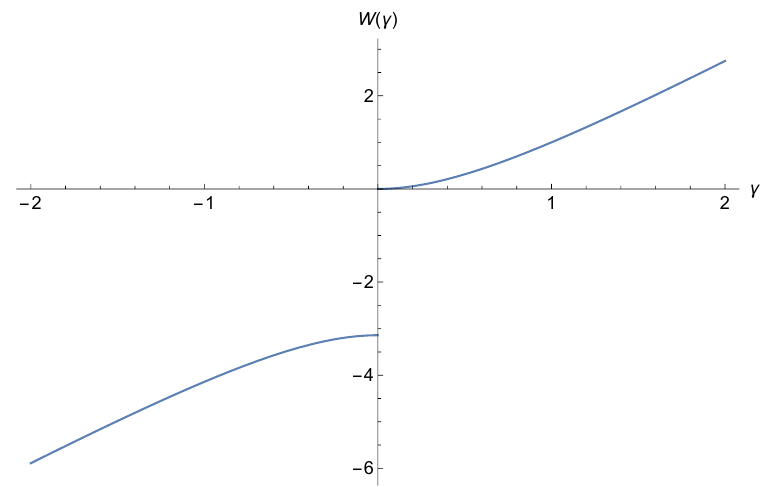
Figure 1: The scaling function for the effective potential W ( γ ) defined in Eq. (14). Note that although W is discontinuous at γ = 0 the potential V that although W is discontinuous at γ = 0, the potential V function of λ at λ =